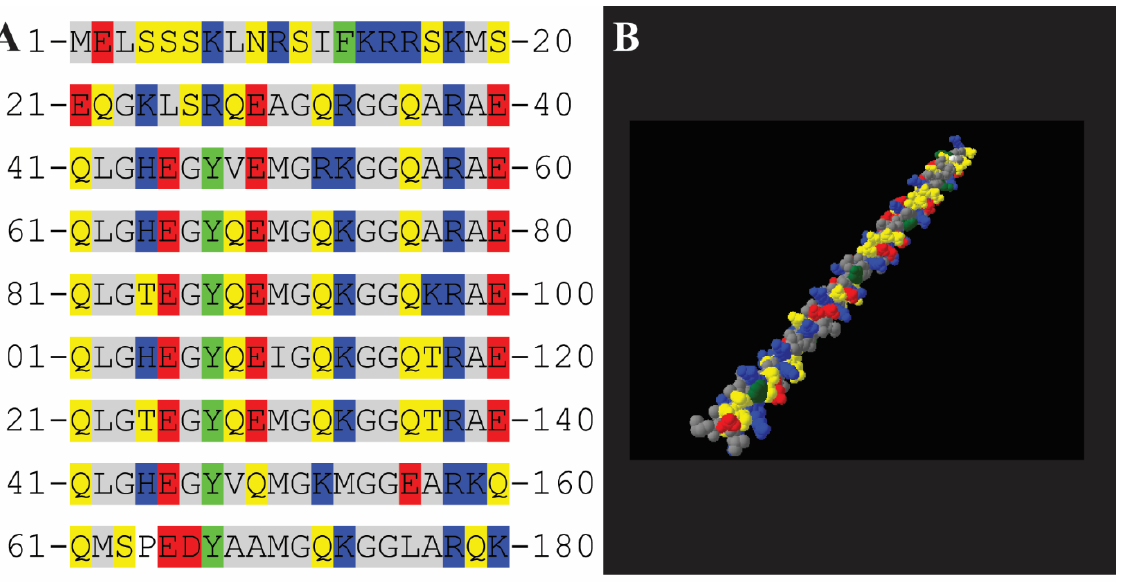
Figure 4. Amino acid sequence features of Af LEA1 where the amino acid properties are labeled by colors representing aromatic (green), polar (yellow), nonpolar (grey), positive (blue), and negative (red) amino acid side chains. ( A ) The amino acid sequence of Af LEA1 is highly repetitive and consists of eight Group 1 LEA domains. ( B ) Projected as an α -helix, Af LEA1 has a distinct hydrophobic face of nonpolar amino acids (gray) but does not have distinctly organized stripes of charged amino acid as described for some Group 3 LEA proteins.